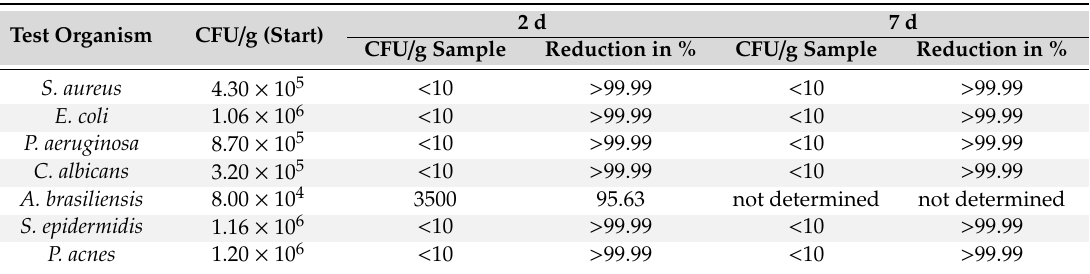
Table 3. Studies on the antimicrobial e ff ects of the OMWW extract on various microorganisms by the suspension method.